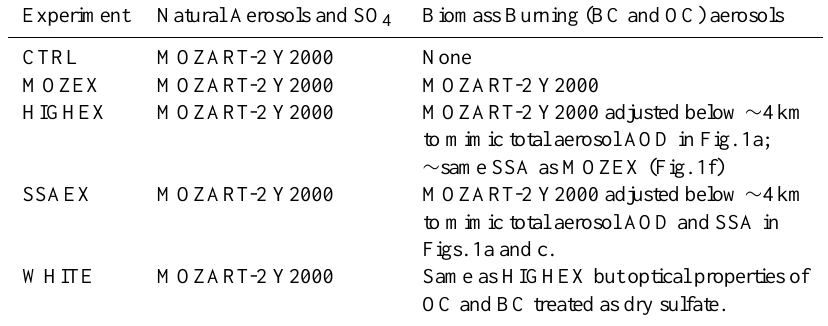
Table 1. Experimental Design. All experiments have the same natural (sea salt plus dust) and sulfate (SO 4 ) distributions from MOZART-2 (Horowitz, 2006). Experiments differ based solely on the prescription of OC and BC distributions. All other forcing agents (e.g. long-lived greenhouse gasses, prescribed observed sea surface temperatures) are held constant. Differencing an experiment with respect to the CTRL case indicates the response of the model to biomass burning aerosol forcing.